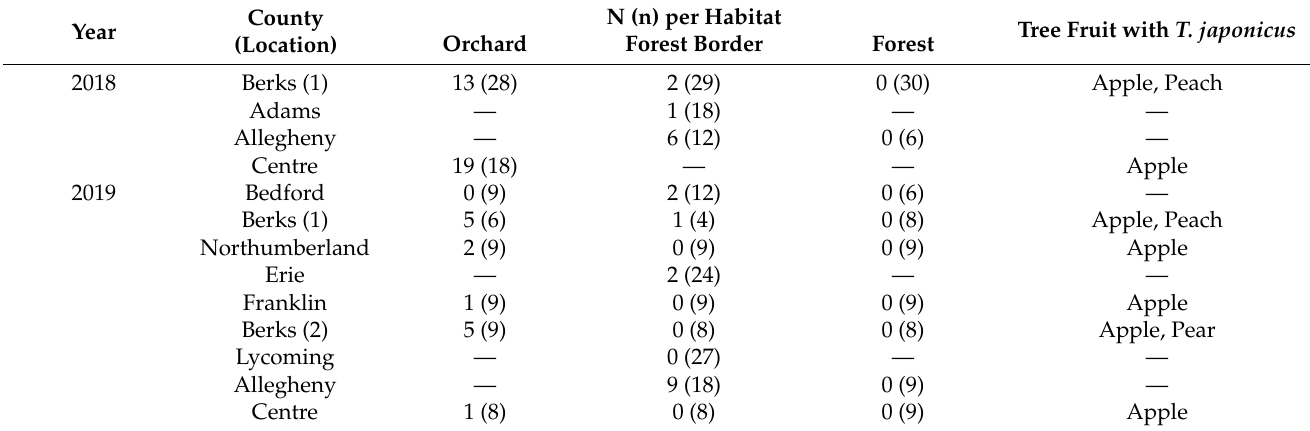
Table 1. Trissolcus japonicus (N = total number) detections on yellow sticky cards (n = number of cards deployed and retrieved) at three habitats sampled in four (2018), and at eight (2019) Pennsylvania counties at and around fruit orchards. N (n) per Habitat Tree Fruit with T. japonicus Year Orchard Forest